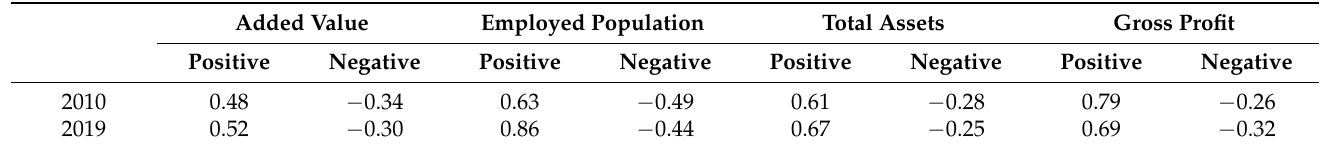
Table 7. Average value of spatial mismatch index in the